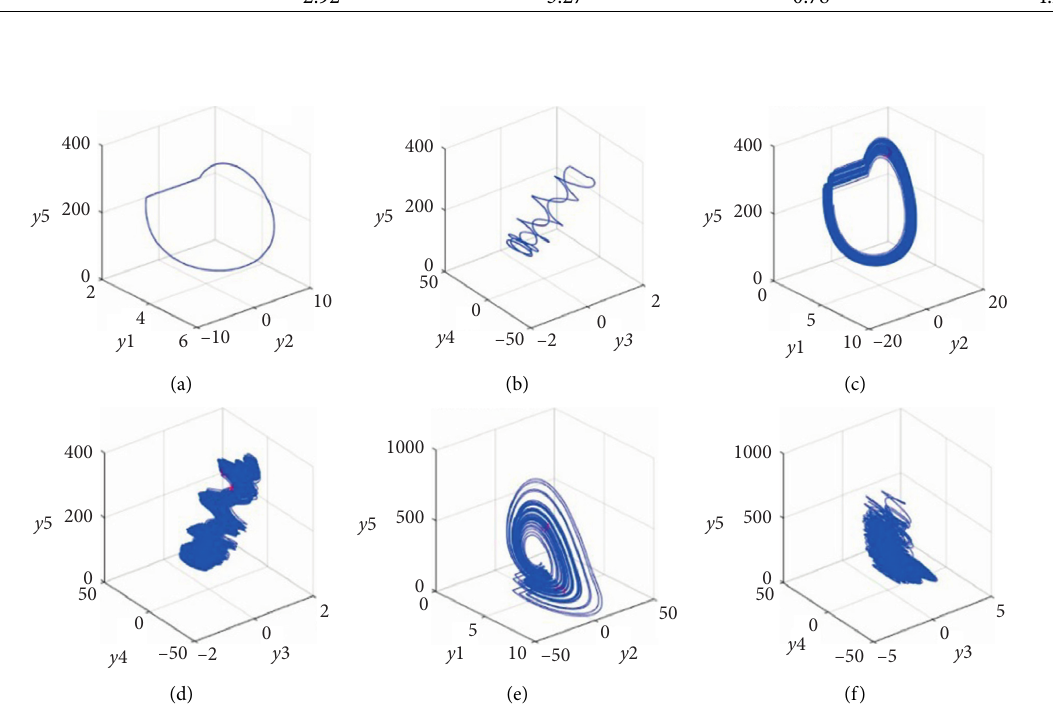
Figure 4: 2-D and 3-D phase portraits of the valve element in both the axial and vertical directions at the water depths. (a) 100m axial vibration, (b) 100m vertical vibration, (c) 150m axial vibration, (d) 150m vertical vibration, (e) 300m axial vibration, and (f) 300m vertical vibration,